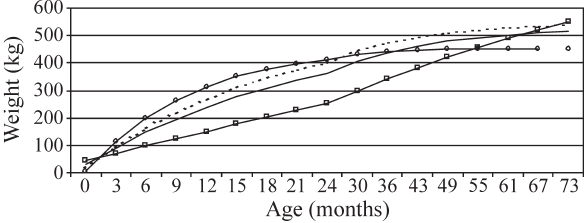
Figure 4 - Simulated growth curves based on high (-o-), low (- (cid:10) -) and av- erage (---) expected progeny differences (EPD) for the maturation rate es- timated according to the Brody model, compared with the observed mean curve (-).